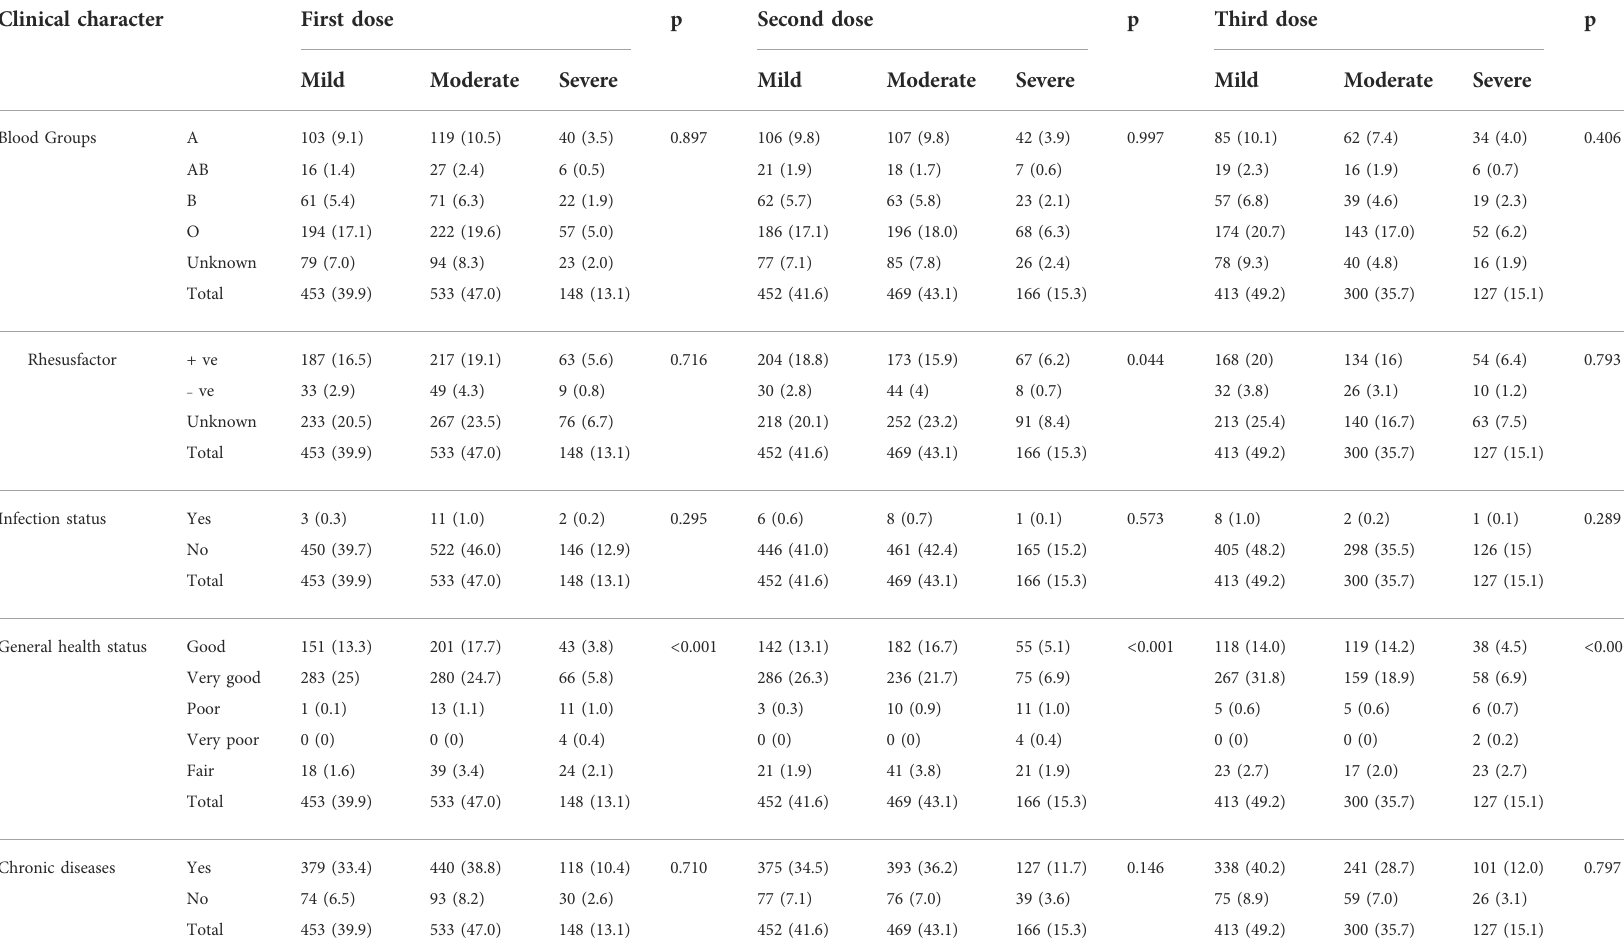
TABLE 6 Correlation between vaccine – related adverse events and participants ’ clinical